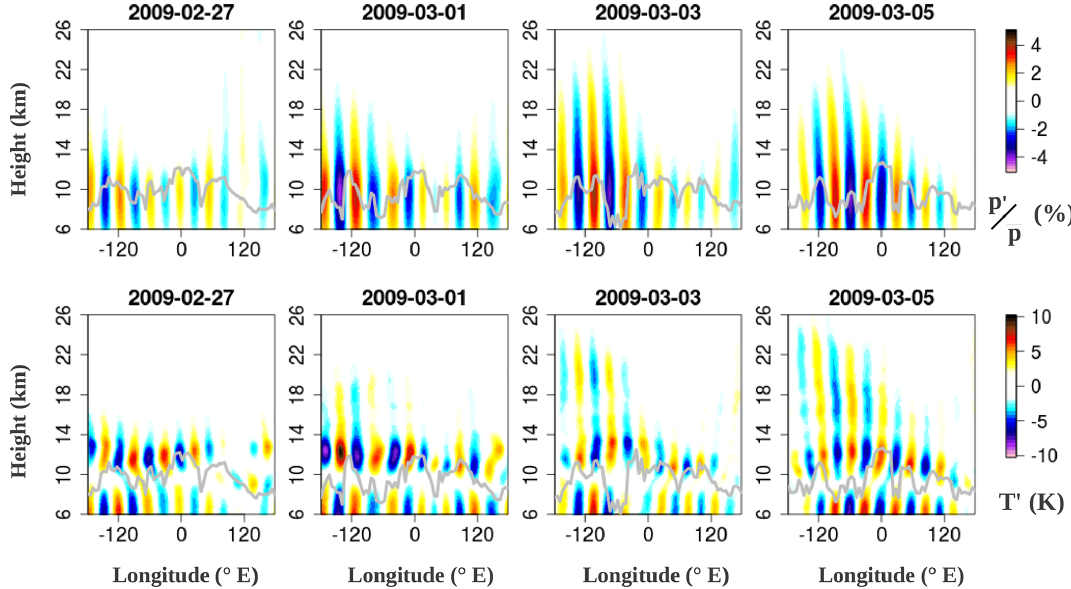
Figure 7. Longitude–height snapshots of (top row) pressure and (bottom row) temperature anomalies of the RWP from Fig. 6 at 50 ◦ N. The grey line denotes the gridded lapse-rate tropopause